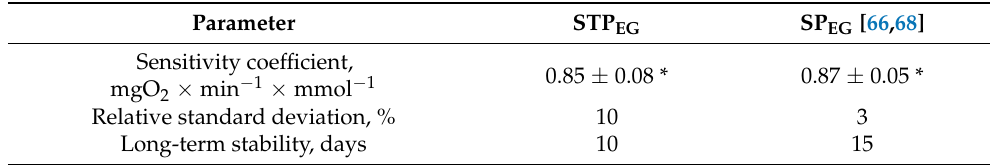
Table 2. The characteristics of biosensors based on the microorganisms immobilized in organosilica composites.